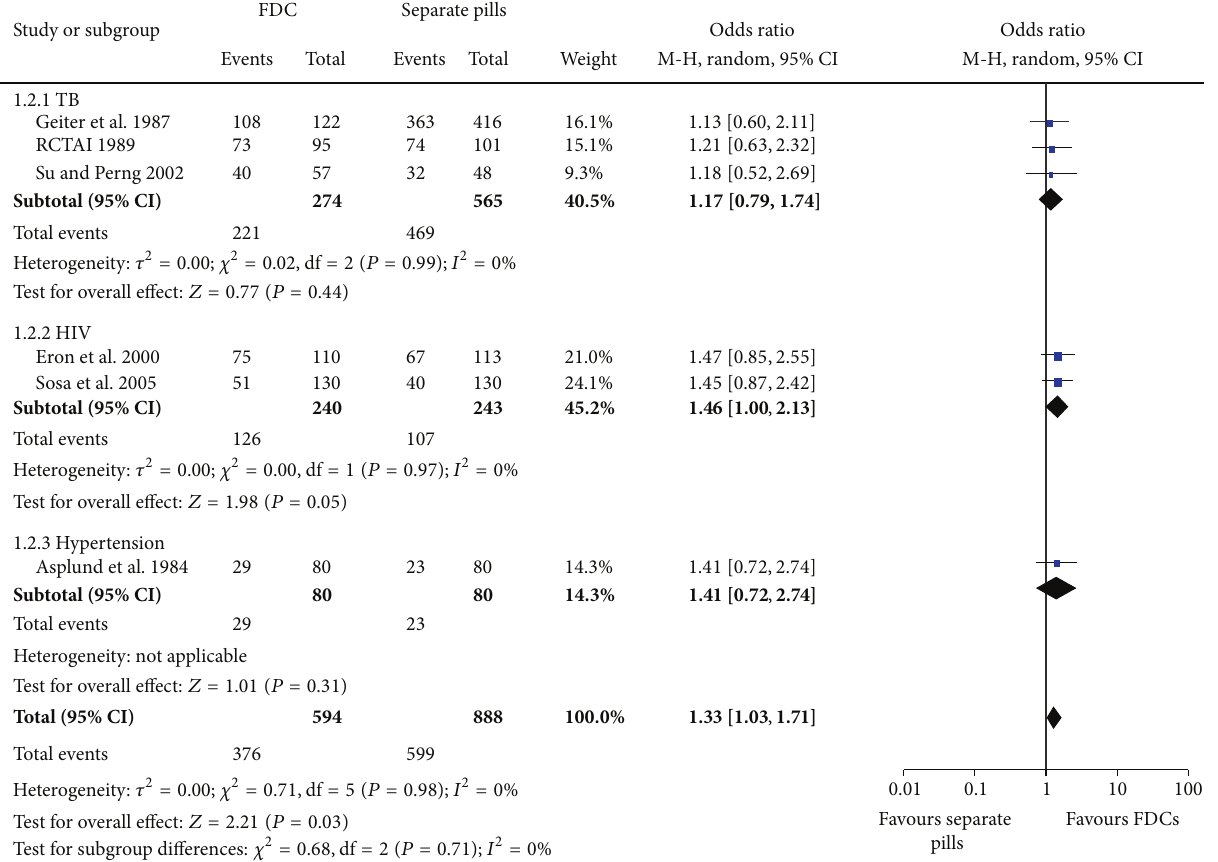
Figure 2: Effect of FDCs versus separate pills on treatment